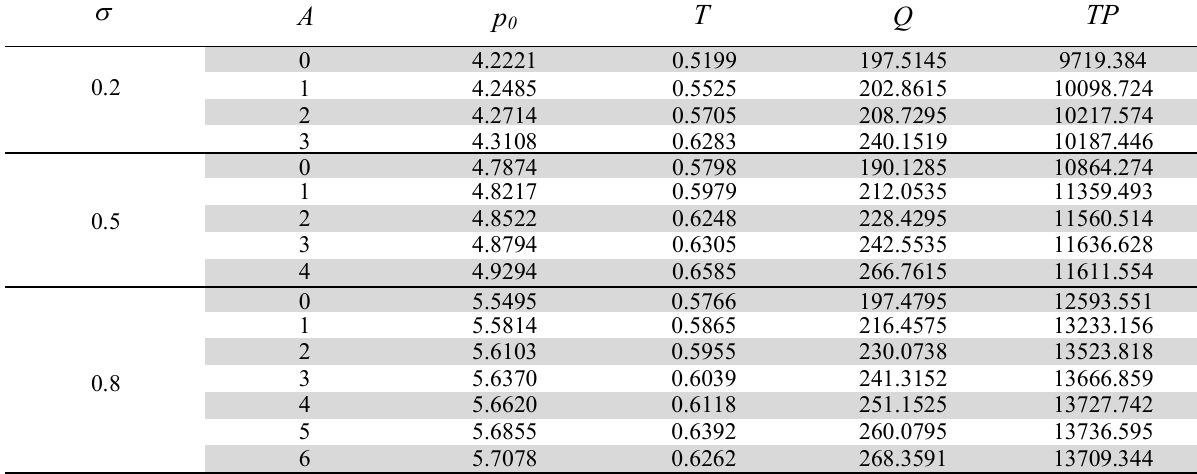
Illustration of solution procedure of the proposed algorithm